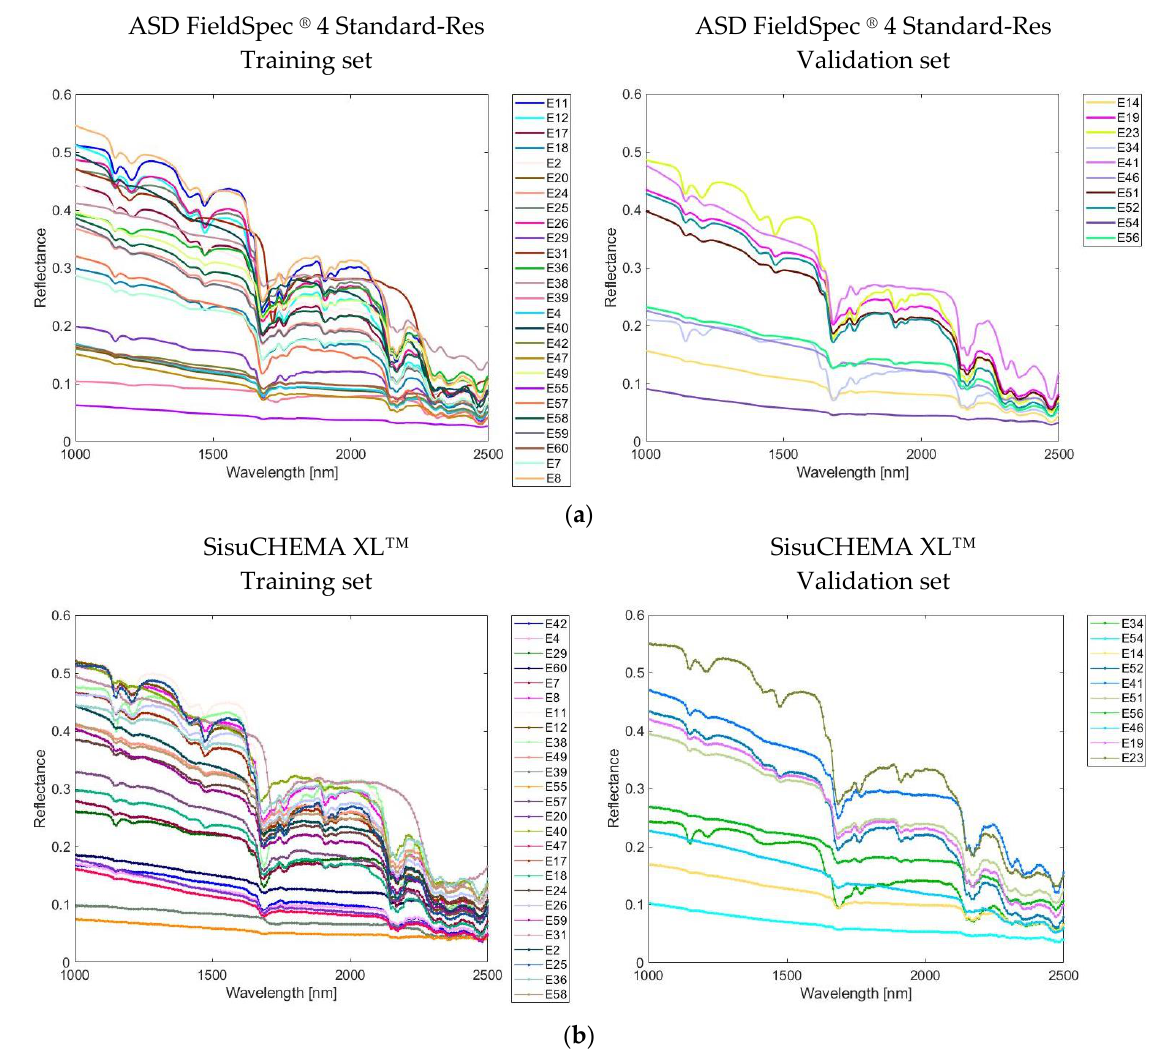
Figure 5. Average raw reflectance spectra (1000–2500 nm) of each plastic scrap collected by ASD FieldSpec ® 4 Standard-Res ( a ) and extracted from ROIs investigated by the SisuCHEMA XL™ ( b ).